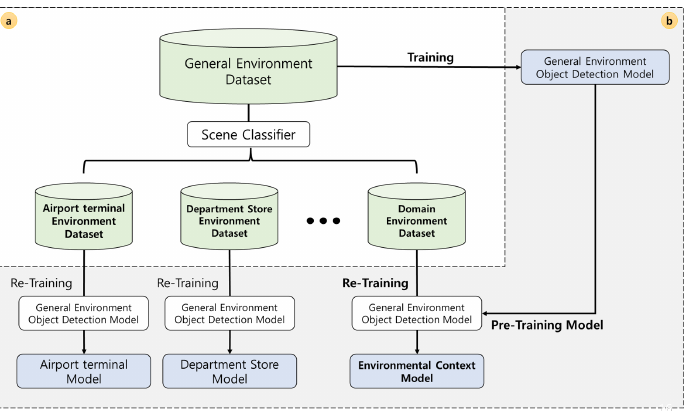
Figure 4. Procedure for developing an environment-specific object detection